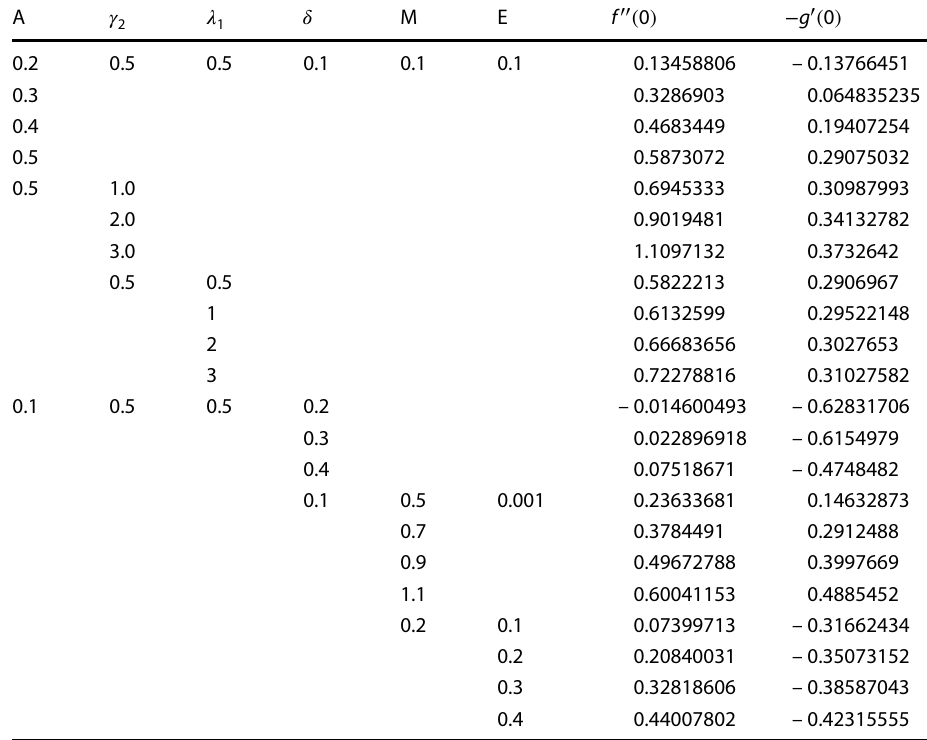
Table 2 Skin friction numerical data when 𝛾 1 = 0.3 , m = 2, Rd = 0.01, Bi = 1, Le = 0.1, Ec = 0.03, Pr = 7.38, Θ t = Nt = Nb =